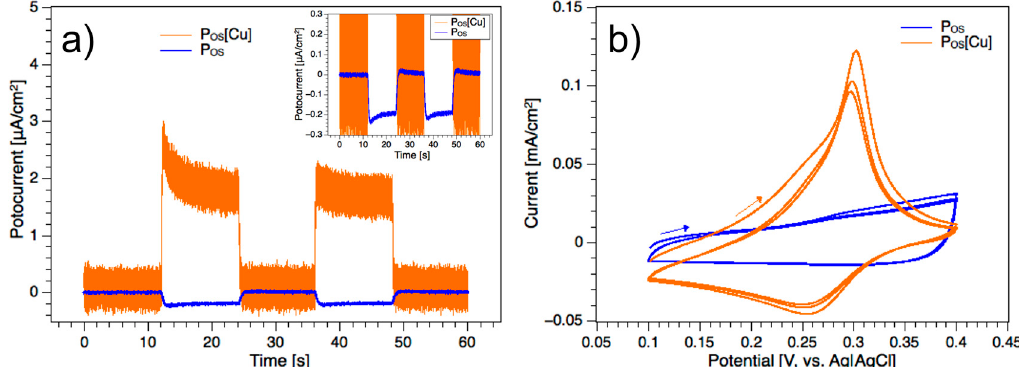
Figure 4. ( a ) Photocurrent response of the polymer and its copper complex in a 0.1 M saline